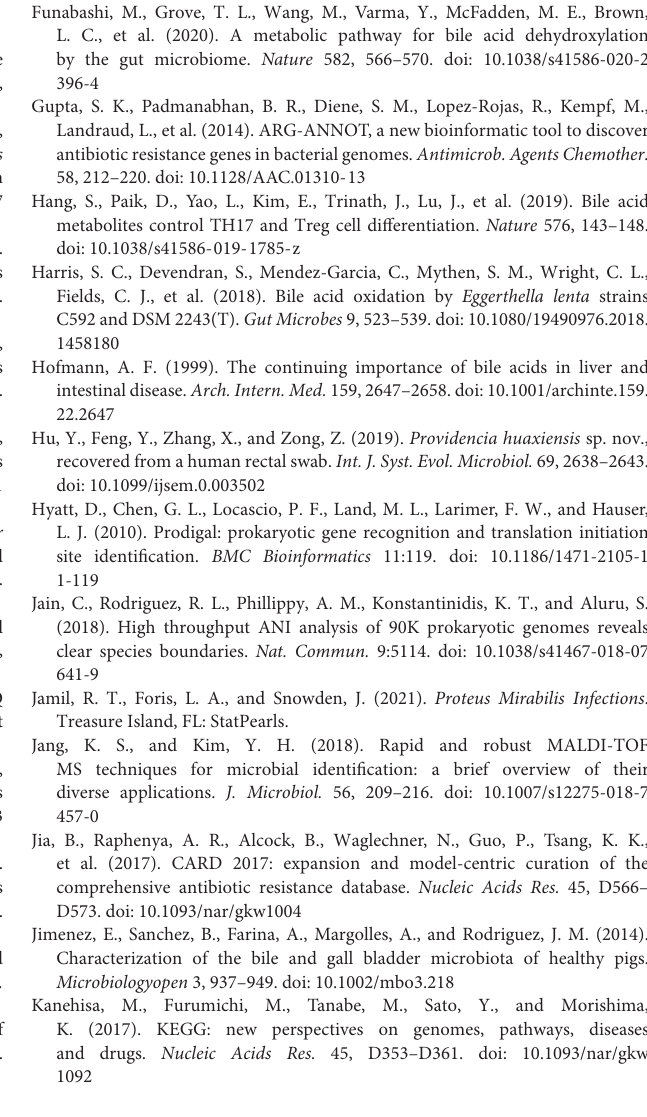
Supplementary Figure 1 | Phylogenetic tree of 35 bile isolates and 1,520 bacterial strains cultivated from the feces. Outer color bars represent the phylum assignment of the